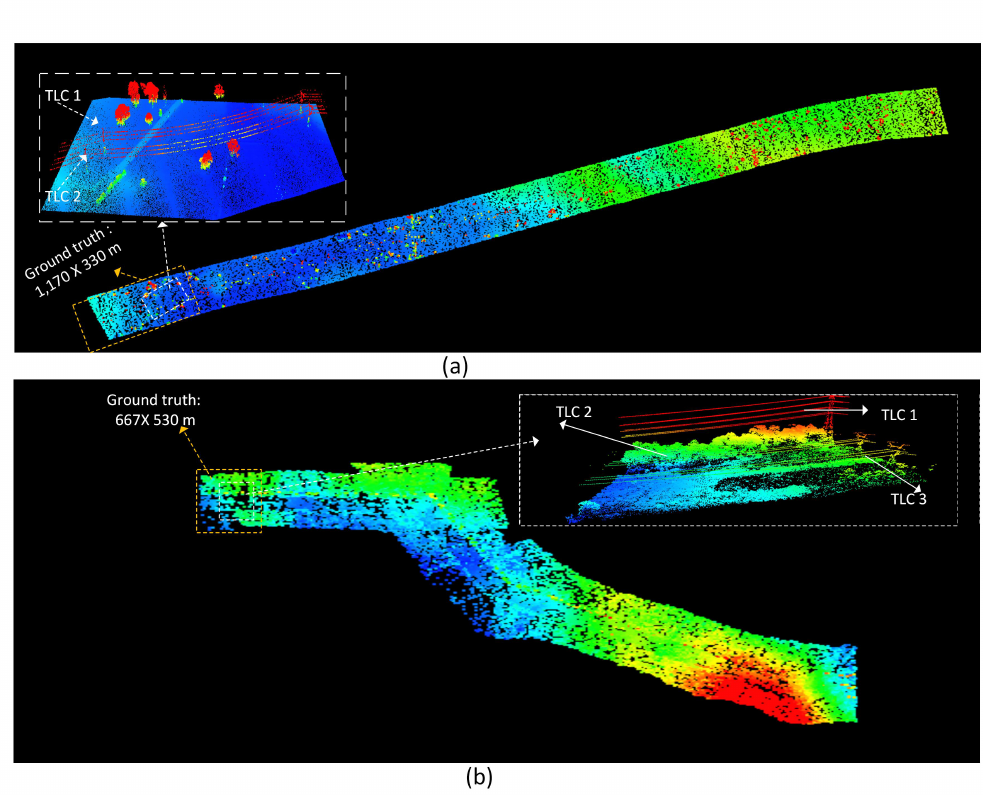
Figure 7. Test data sets: ( a ) Maindample (MDP) and ( b ) Bindebango